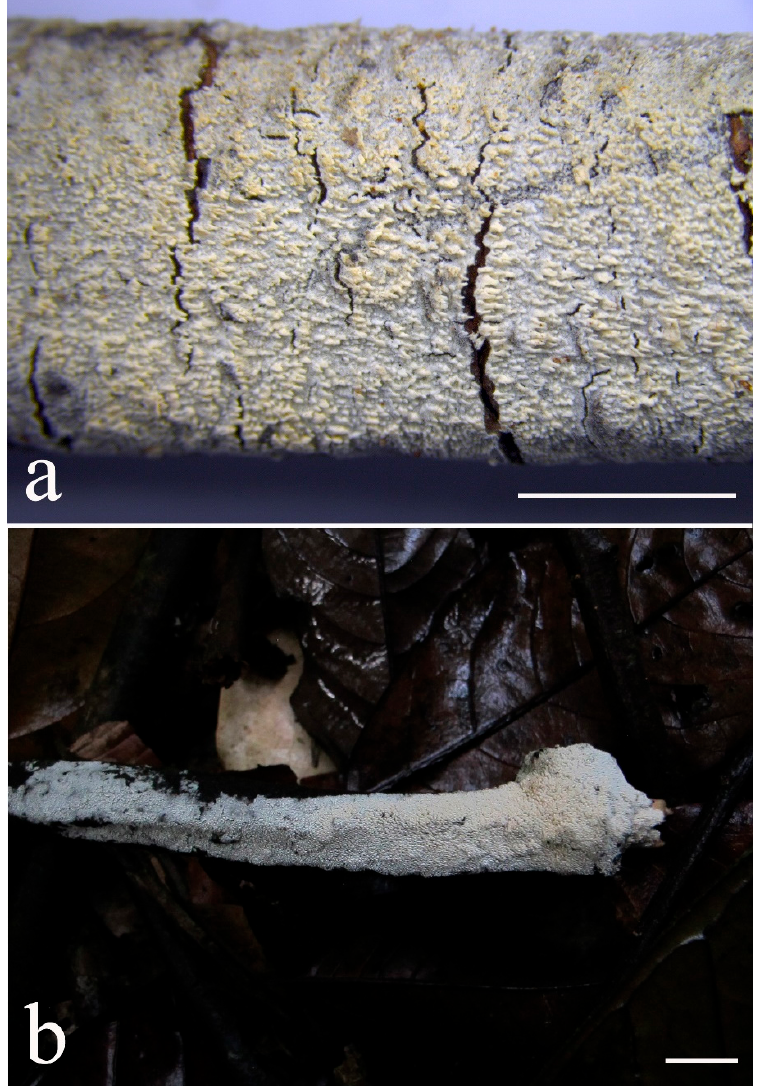
Figure 12. Basidiocarps of Hyphodontia wongiae. ( a ) LWZ 20180414-16 (holotype); ( b ) LWZ 20180417-8 (paratype).—Scale bars: a = 5 mm; b = 1 cm.